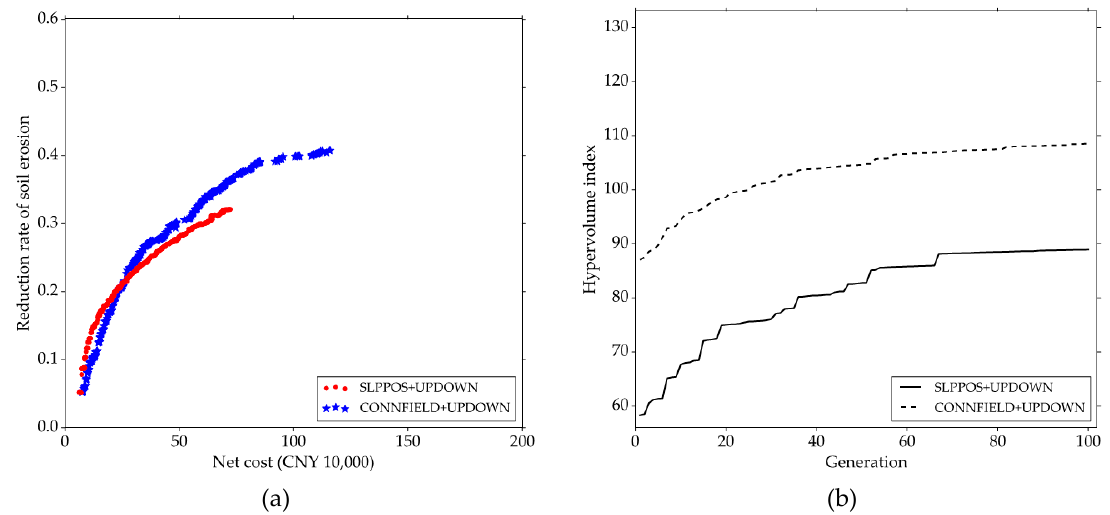
Figure 8. Comparisons between two types of BMP configuration units applied with the UPDOWN strategy: ( a ) near-optimal Pareto solutions of the 100th generation, and ( b ) the hypervolume index with generations.